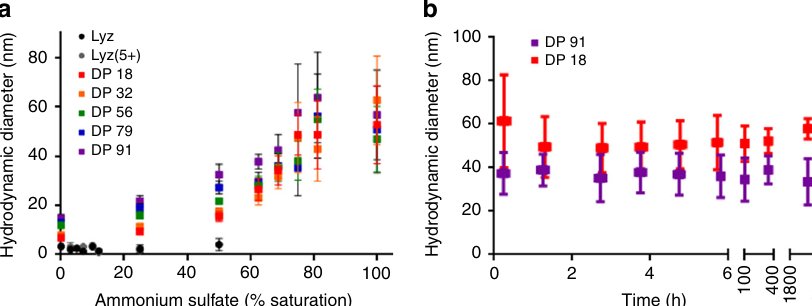
Fig. 3 Dynamic light scattering data to measure hydrodynamic diameters. a Lyz(5 + )pCBMA conjugates in increasing ammonium sulfate saturation for DP 18, DP 32, DP 56, DP 79, and DP 91. All conjugates increased in hydrodynamic diameter with increased ammonium sulfate concentration. Native Lyz and Lyz(5 + ) hydrodynamic diameters were not able to be measured after 50% saturation because samples precipitated. b Lyz(5 + )pCBMA DP 18 and DP 91 hydrodynamic diameter stability over 2.5 months in 100% saturated ammonium sulfate. Data are presented as number distribution averages ± 1 standard deviation errors from n = 3